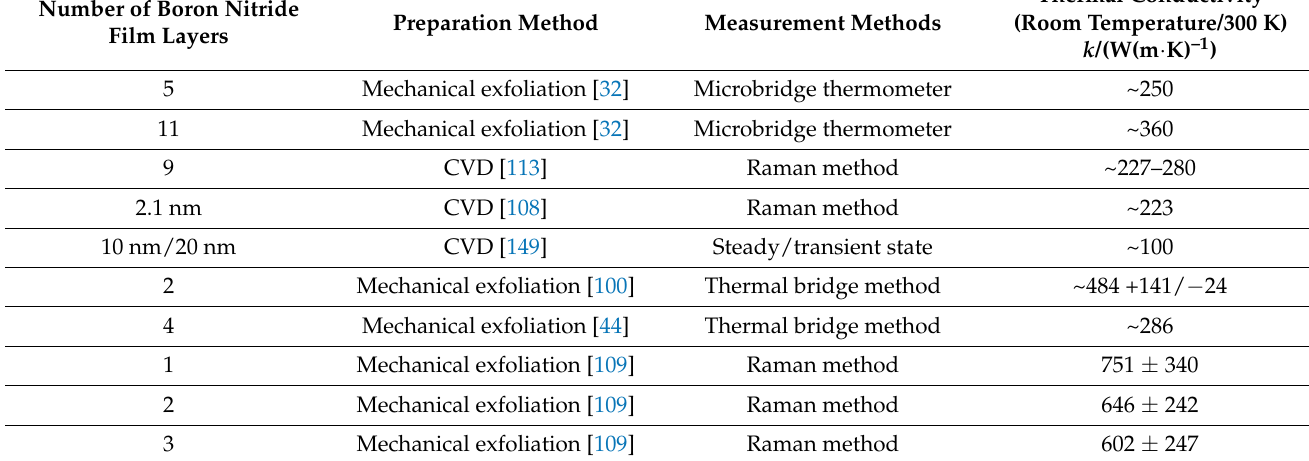
Table 2. Experimental results of thermal conductivity of suspended single-/few-layer h-BN in different kinds of